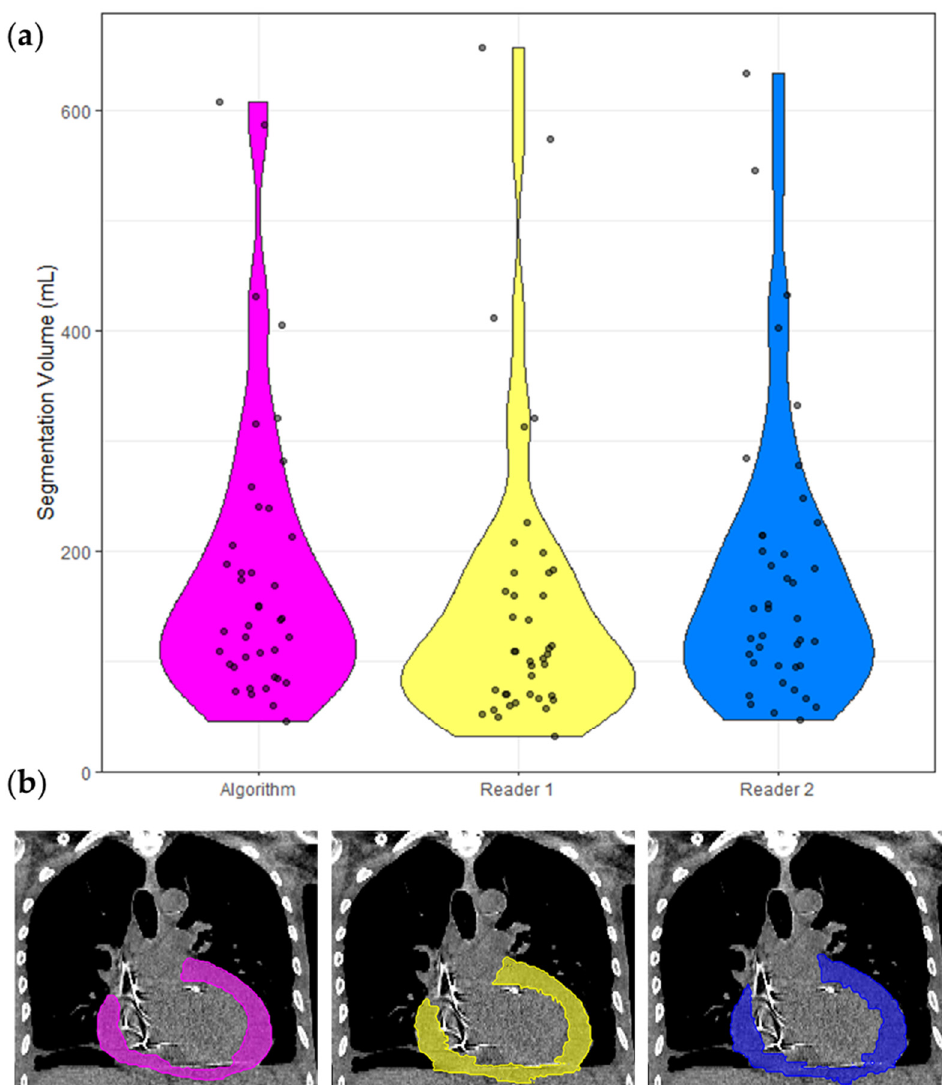
Figure 3. Segmentation volumes and a corresponding example CT with segmentation masks. ( a ) Violin plots of the segmentation volumes of the 40 cases in the inter-reader dataset. Each violin is color coded to match the corresponding segmentation in ( b ). Pink = model, yellow = Reader 1, blue = Reader 2. ( b ) Non-contrast CT chest of a 65-year-old shown with soft tissue windowing. Reader 1 segmented 183 mL, Reader 2 segmented 201 mL, and the model segmented 192 mL.